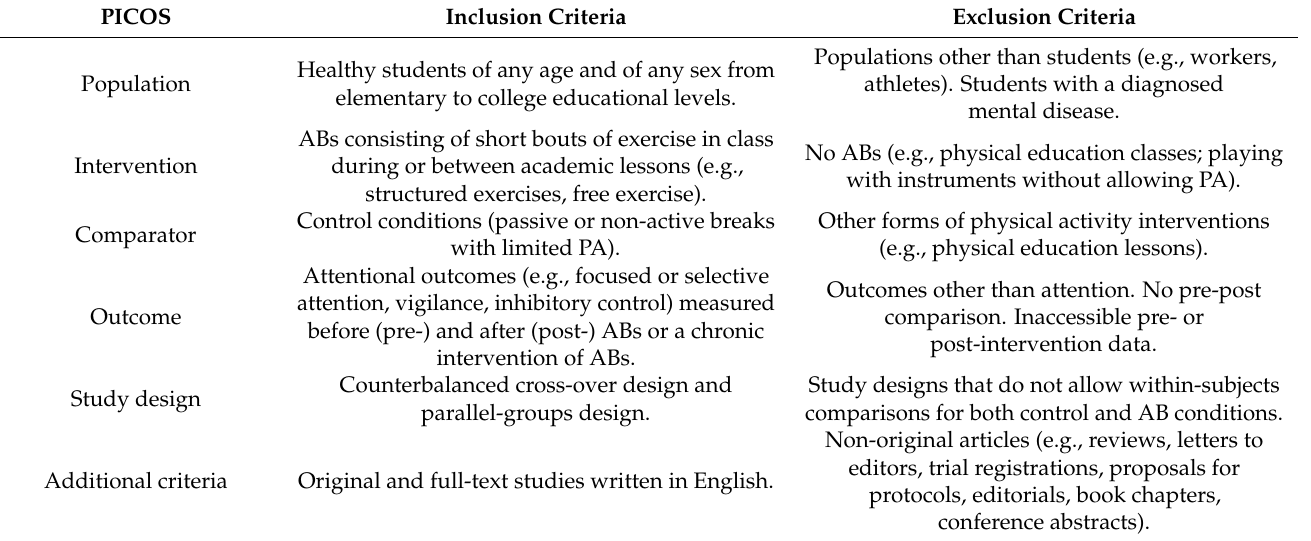
Table 1. Inclusion and exclusion criteria following the P.I.C.O.S. approach. PICOS Inclusion Criteria Exclusion Criteria